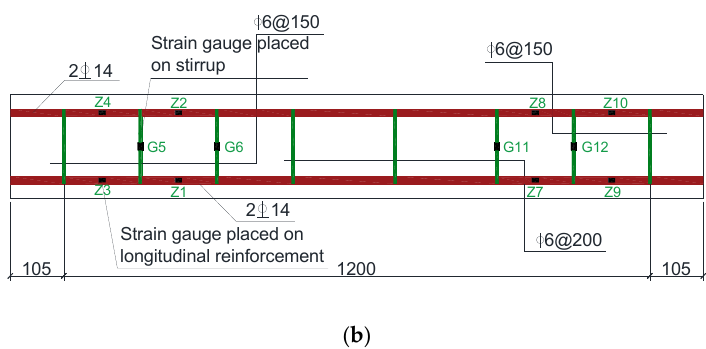
Figure 5. The arrangement of the strain gauges. ( a ) The layout of strain gauges on the steel tubes and RAC beam; ( b ) The layout of strain gauges on the longitudinal reinforcements and stirrups.